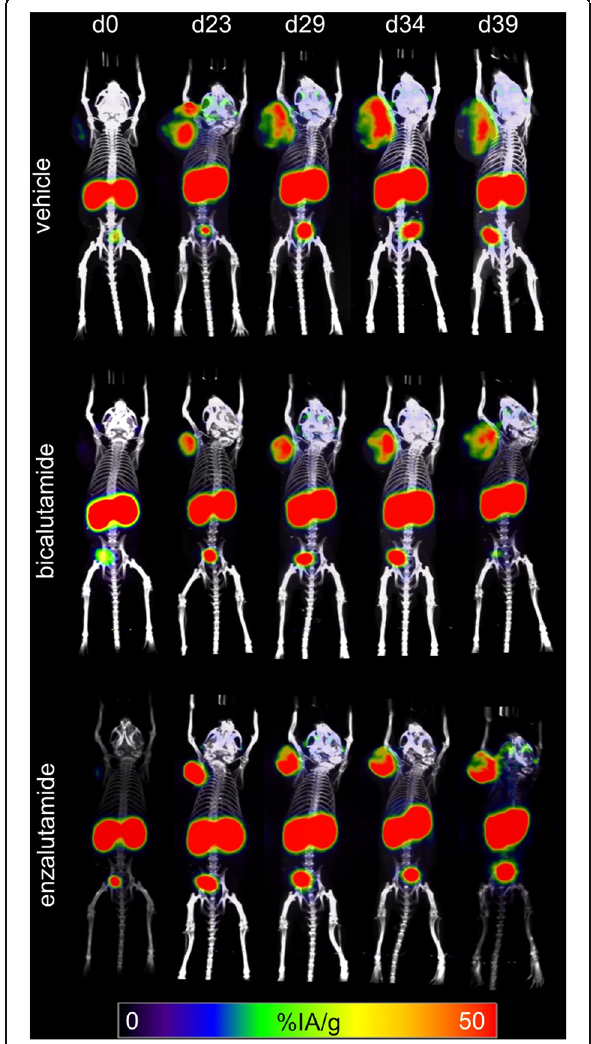
Fig. 2 68 Ga-PSMA11 PET/CT. C4-2 tumor-bearing mice were imaged with 68 Ga-PSMA11 PET/CT on days 0, 23, 29, 34, and 39 post start of therapy with vehicle (top row), BIC (middle), or ENZ (bottom row). Representative PET/CT images of 1 mouse per treatment group are